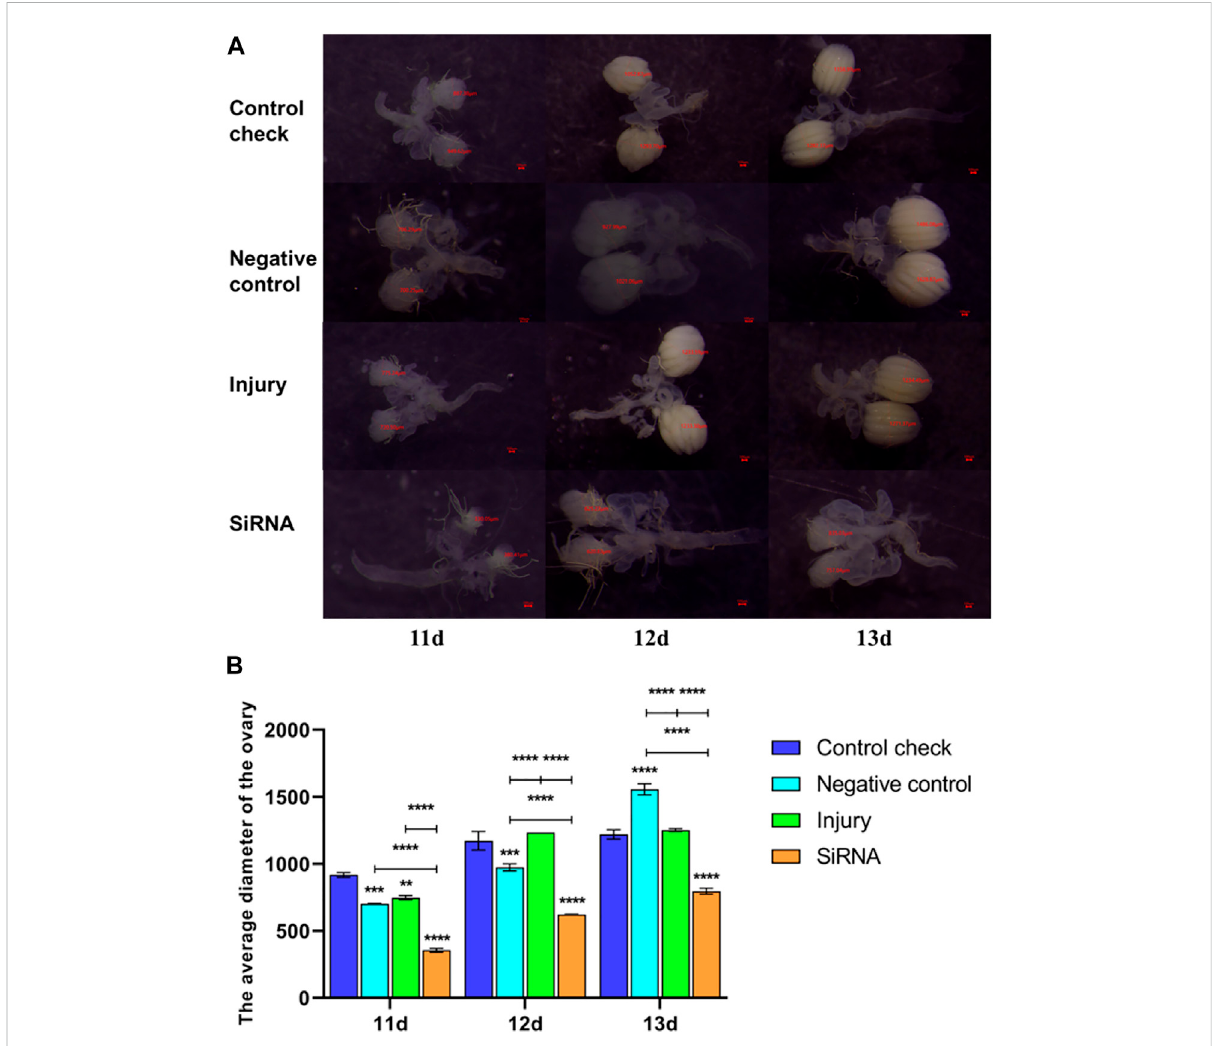
FIGURE 8 Effects of interfering target genes on ovarian development of Z. cucurbitae (Coquillett) after the 25 ° C treatment for 1 h. (A) Rate of ovarian development. The red line denotes the diameter of the ovary ( μ m). (B) Average diameter of the ovary ( F (3, 24) = 223.1, p < 0.0001; F (2, 24) = 339.6, p < 0.0001; F (6, 24) = 27.24, p < 0.0001). All values in the fi gure are presented as mean ± standard error. *, **, ***, and **** above the histograms indicate the values that differ signi fi cantly between treatments p ≤ 0.05, p ≤ 0.01, p ≤ 0.001, and p ≤ 0.0001,